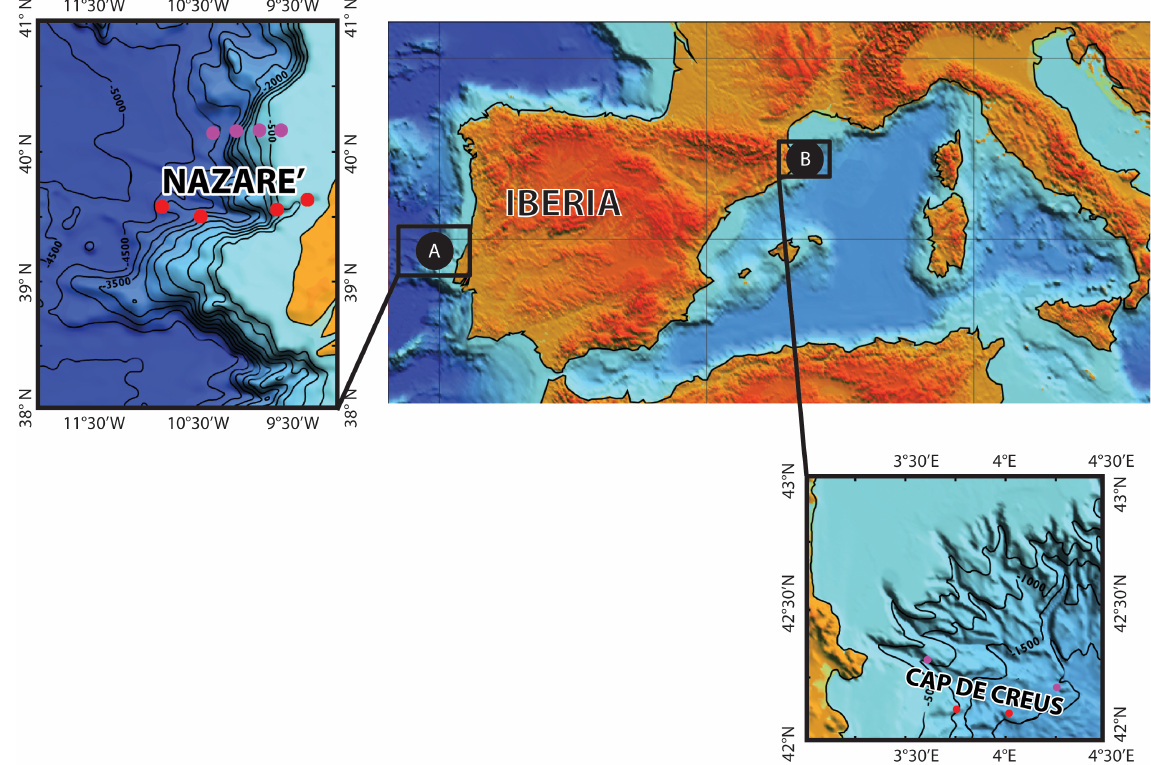
Fig. 1. Study area and sampling locations in the Portuguese (A) and Catalan (B) margins, offshore west and east Iberia,